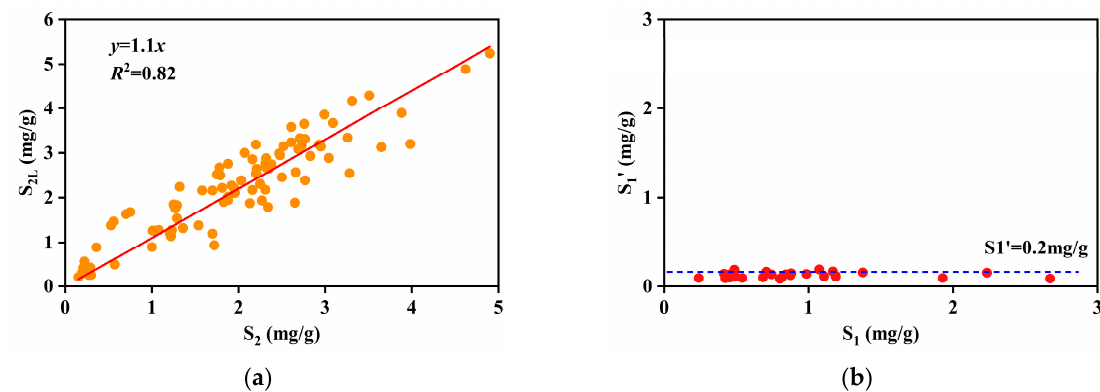
Figure 4. Relationships between room-temperature and liquefrozen shales values of S 2 ( a ) and relationships between before and after oil washing values of S 1 ( b ).